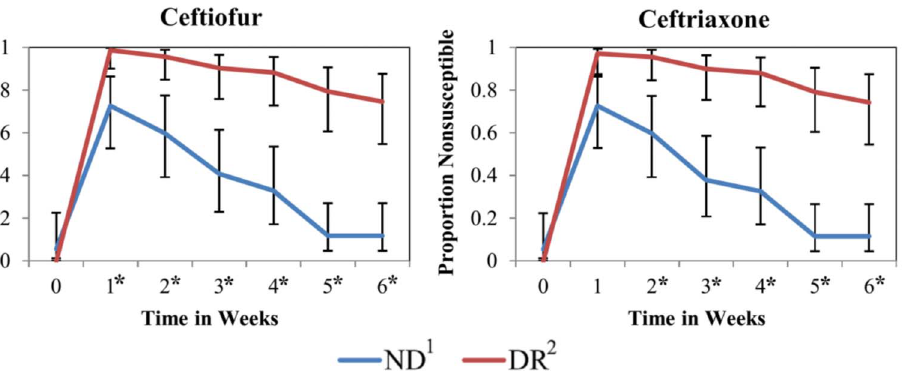
Fig. 3. Proportion of E. coli nonsusceptible to ceftiofur and ceftriaxone by milk feeding treatment at the calf level over time in weeks. Error bars represent 95% confidence interval of the least square mean. 1. Calves fed raw milk without the addition of sub-MICs of antimicrobial drugs. 2. Calves fed raw milk with the addition of sub-MICs of ceftiofur, penicillin, ampicillin, and oxytetracycline from birth to 6 weeks of age. *Sampling weeks where the proportion of resistance was significantly different between NR and